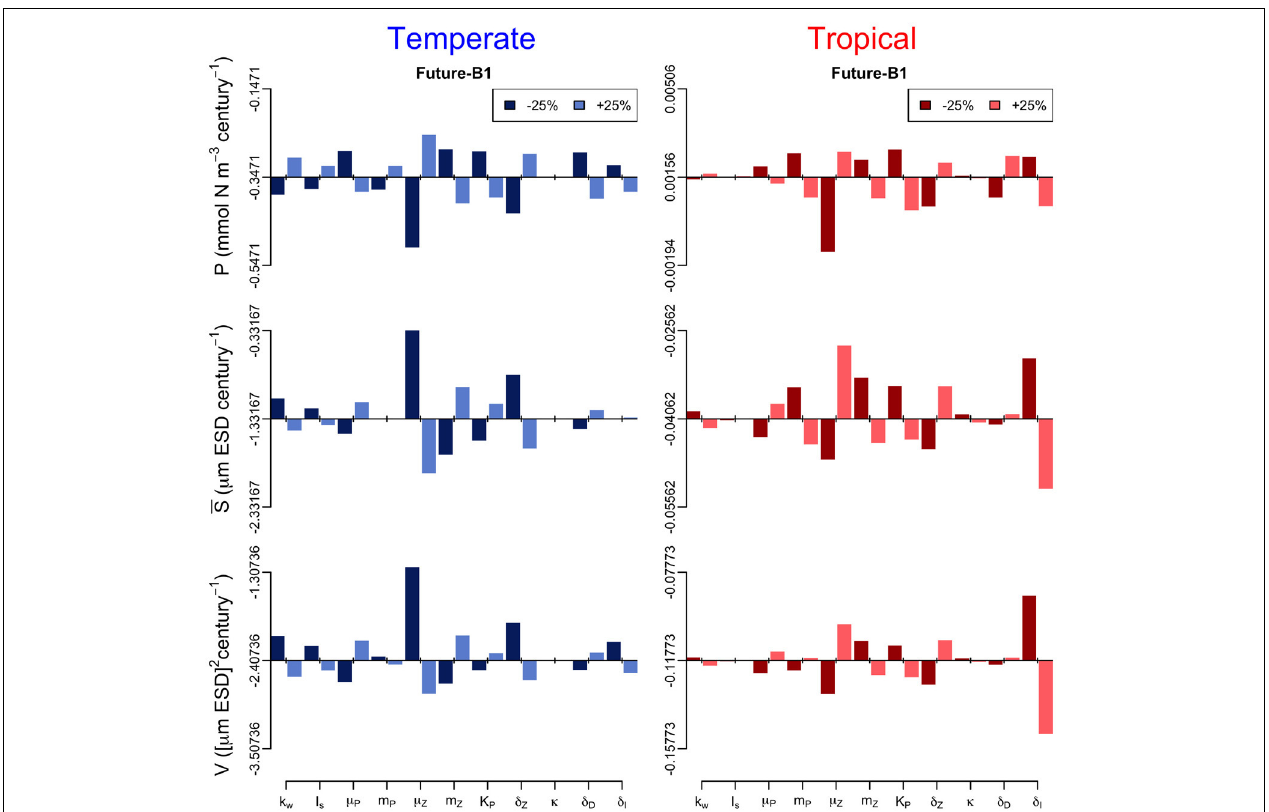
FIGURE 8 | Sensitivity analysis of the phytoplankton state variables (P, S, and V) to ± 25% changes in the values of the model parameters for the future-B1 period. The origin of each panel corresponds to the magnitude of